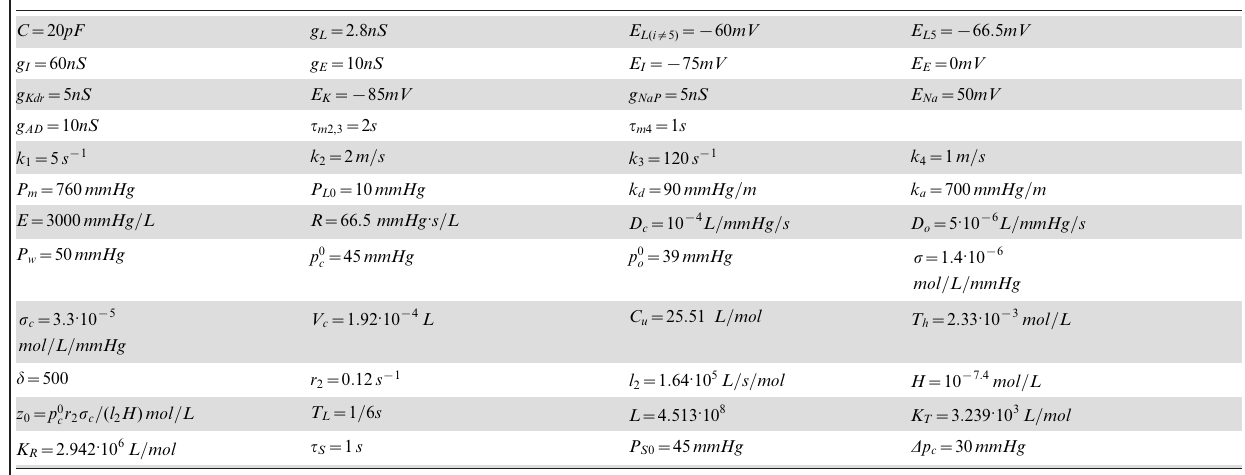
Table 2. Parameters of the